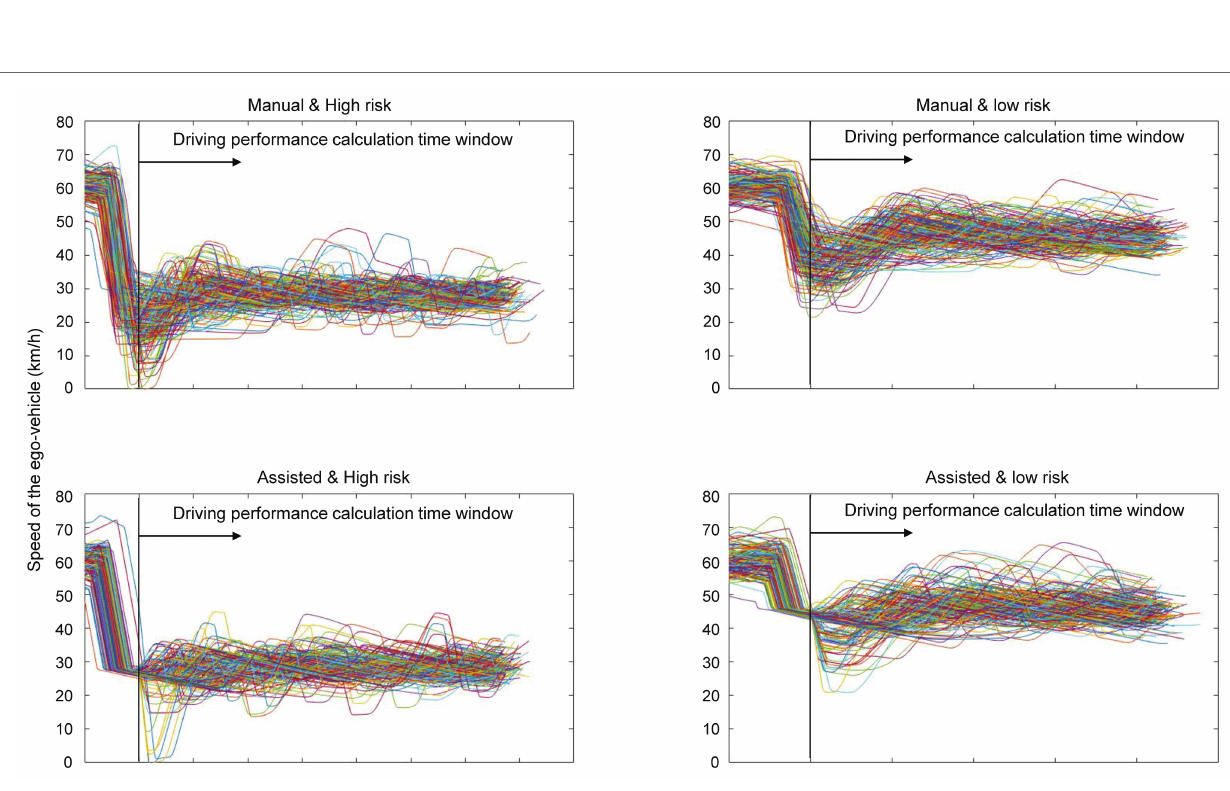
FIGURE 5 | Plots of ego-vehicle speed in the calculation time window of each